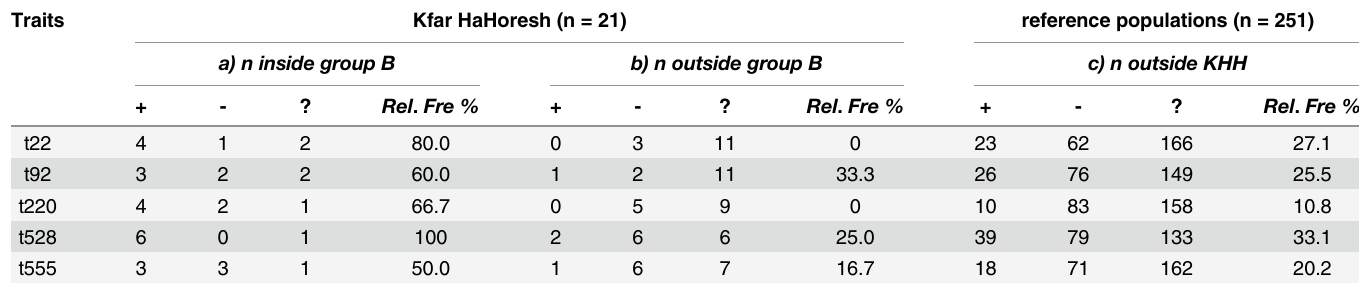
more similarities with the joint data set, than with the frequency within the groups A and/or B. Table 8. Frequencies of group defining traits for Group B.